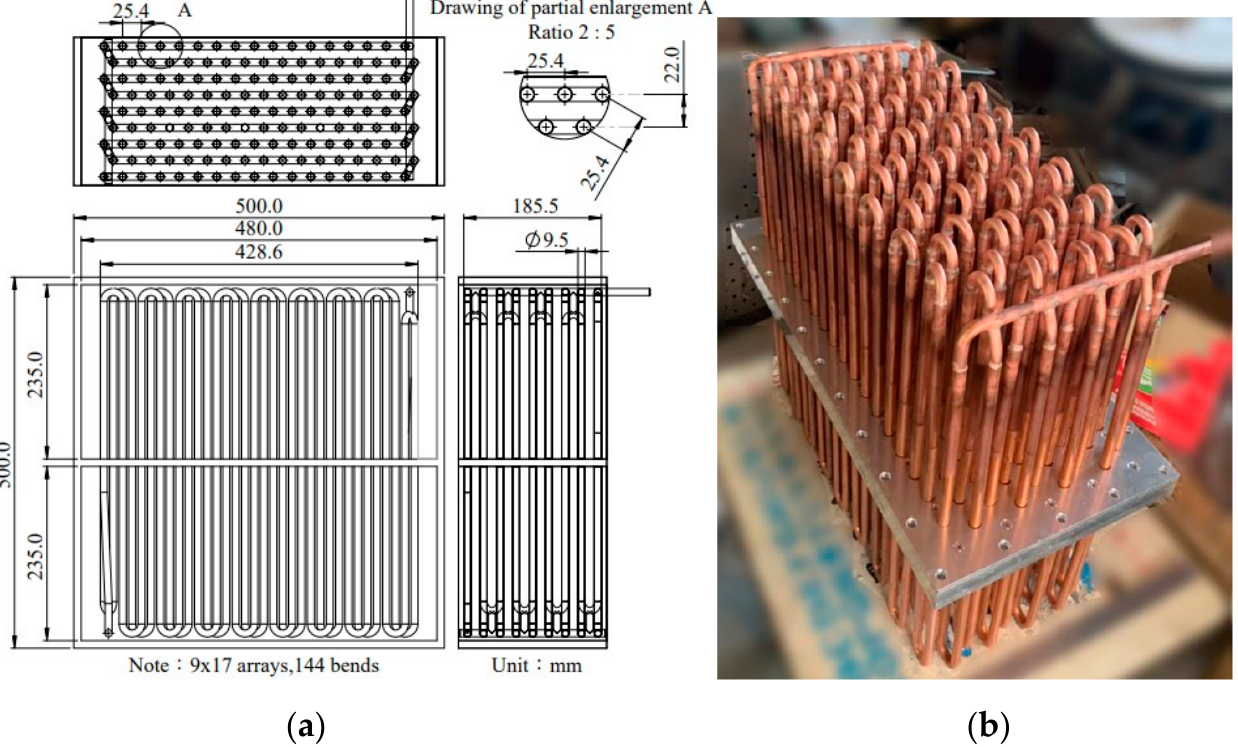
Figure 2. ( a ) The detailed configuration of the present HPHX. ( b ) An actual example (unit: mm ).